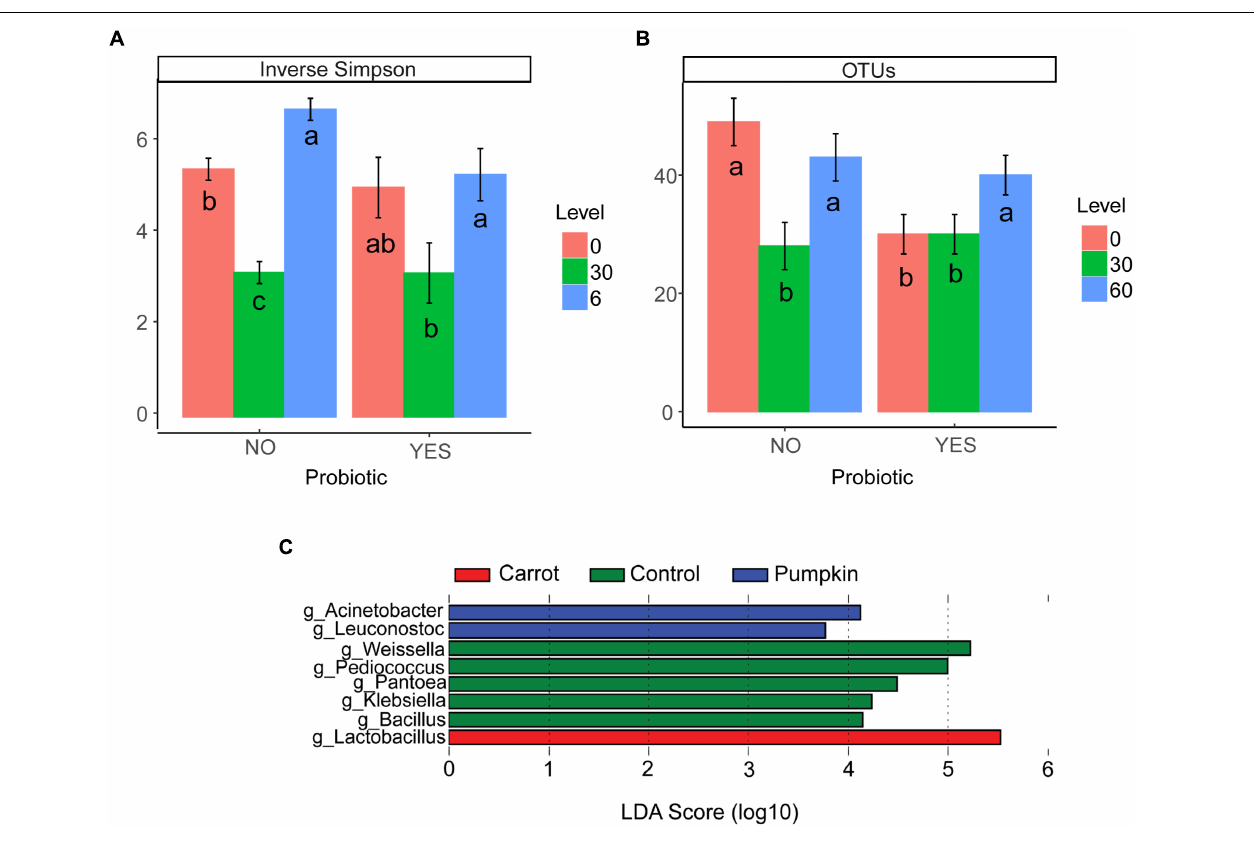
FIGURE 2 | (A) Inverse Simpson’s diversity index and (B) the number of OTUs in ensiled samples that were influenced by vegetable level ( P ≤ 0.01) when compared with probiotic use. When split by probiotic use, there was no effect of vegetable type ( P ≥ 0.14; data not presented). Letters a–c indicate differences within probiotic treatments ( P ≤ 0.05). Differentially abundant genera (C) in the microbiota of sorghum ensiled as a control, or with carrot or pumpkin supplementation for 70 days using the linear discriminant analysis effect size (LEfSe) method.